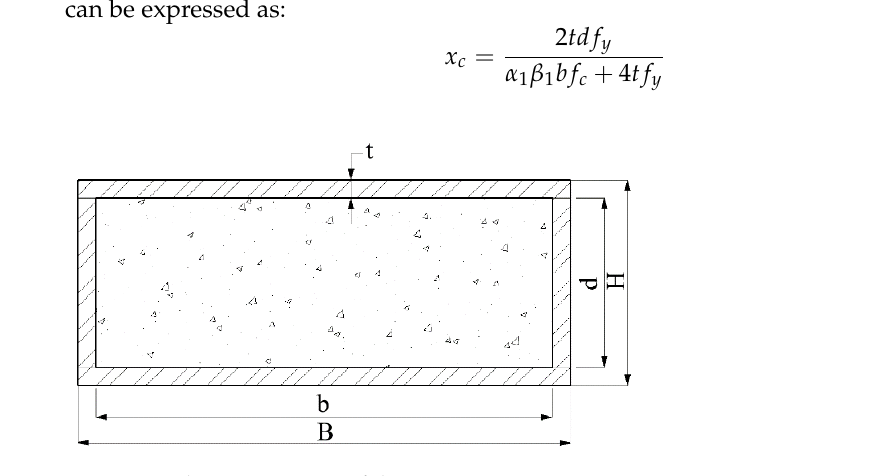
Figure 14. The cross-section of the specimen.